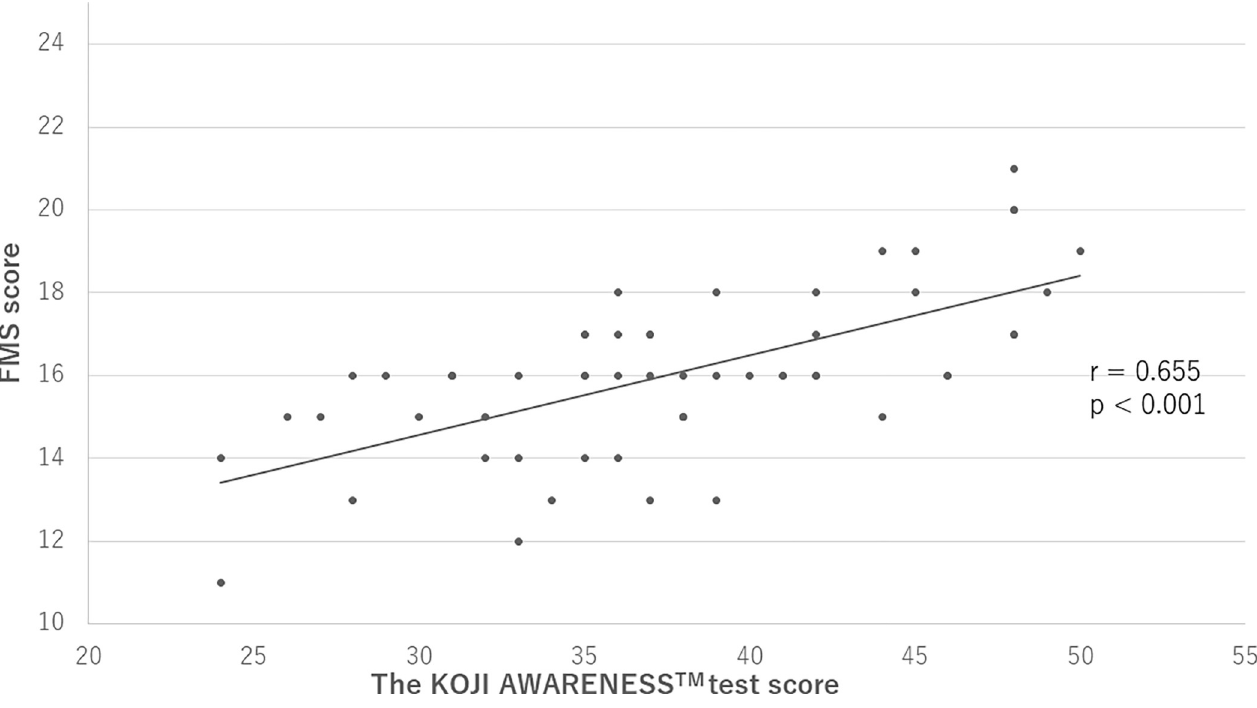
Fig 1. Scatter plot of the FMS score vs. the KOJI AWARENESS TM score (N = 57). FMS, Functional movement screening.